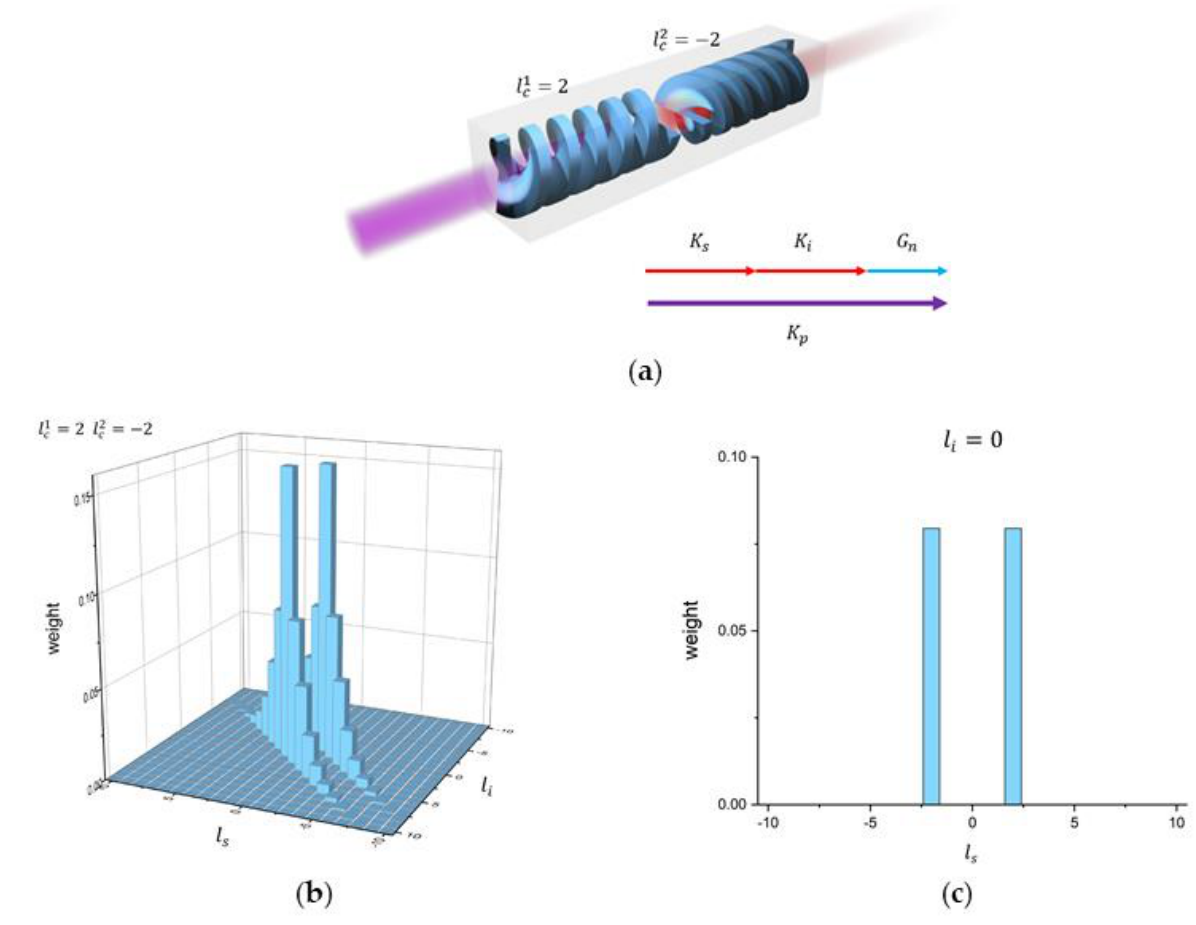
Figure 4. ( a ) The incident light is a Gaussian mode. The NPC sample consists of two spiral structures of opposite topological charges. ( b ) The normalized spiral spectrum with l 1 c = 2, l 2 c = − 2. ( c ) The spiral spectrum of the signal light when the idler light is projected onto the fundamental mode.